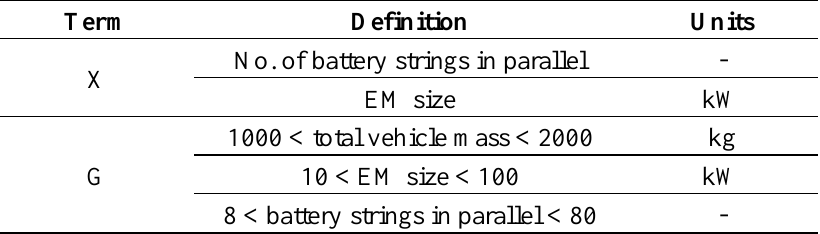
Table 6. Decision variables (X) and constraints